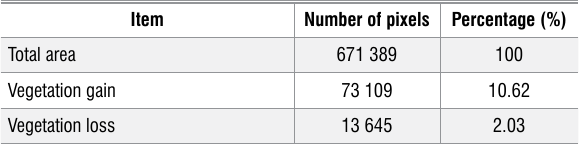
Vegetation change statistics between 2007 and 2017 Item Number of pixels Percentage (%) Total area Vegetation gain Vegetation loss